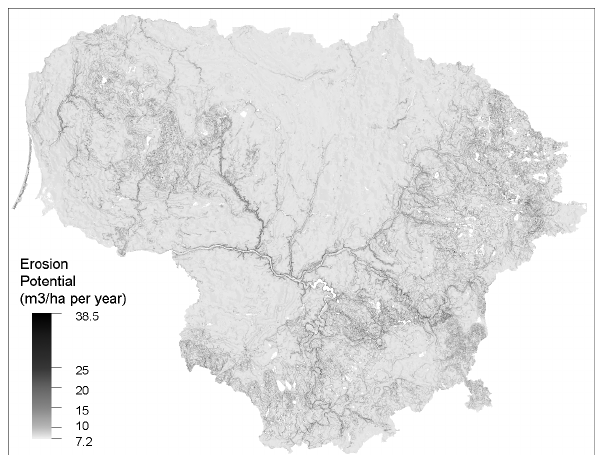
Fig 7 . Erosion potential of Lithuania